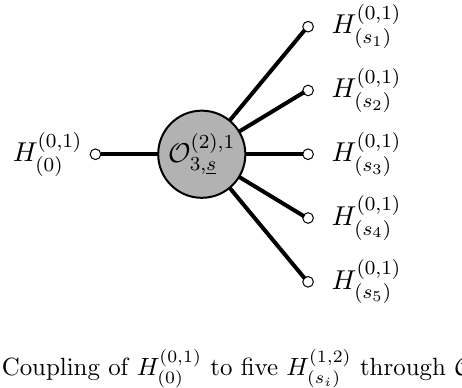
Figure 6 . Coupling of H (0 ; 1)